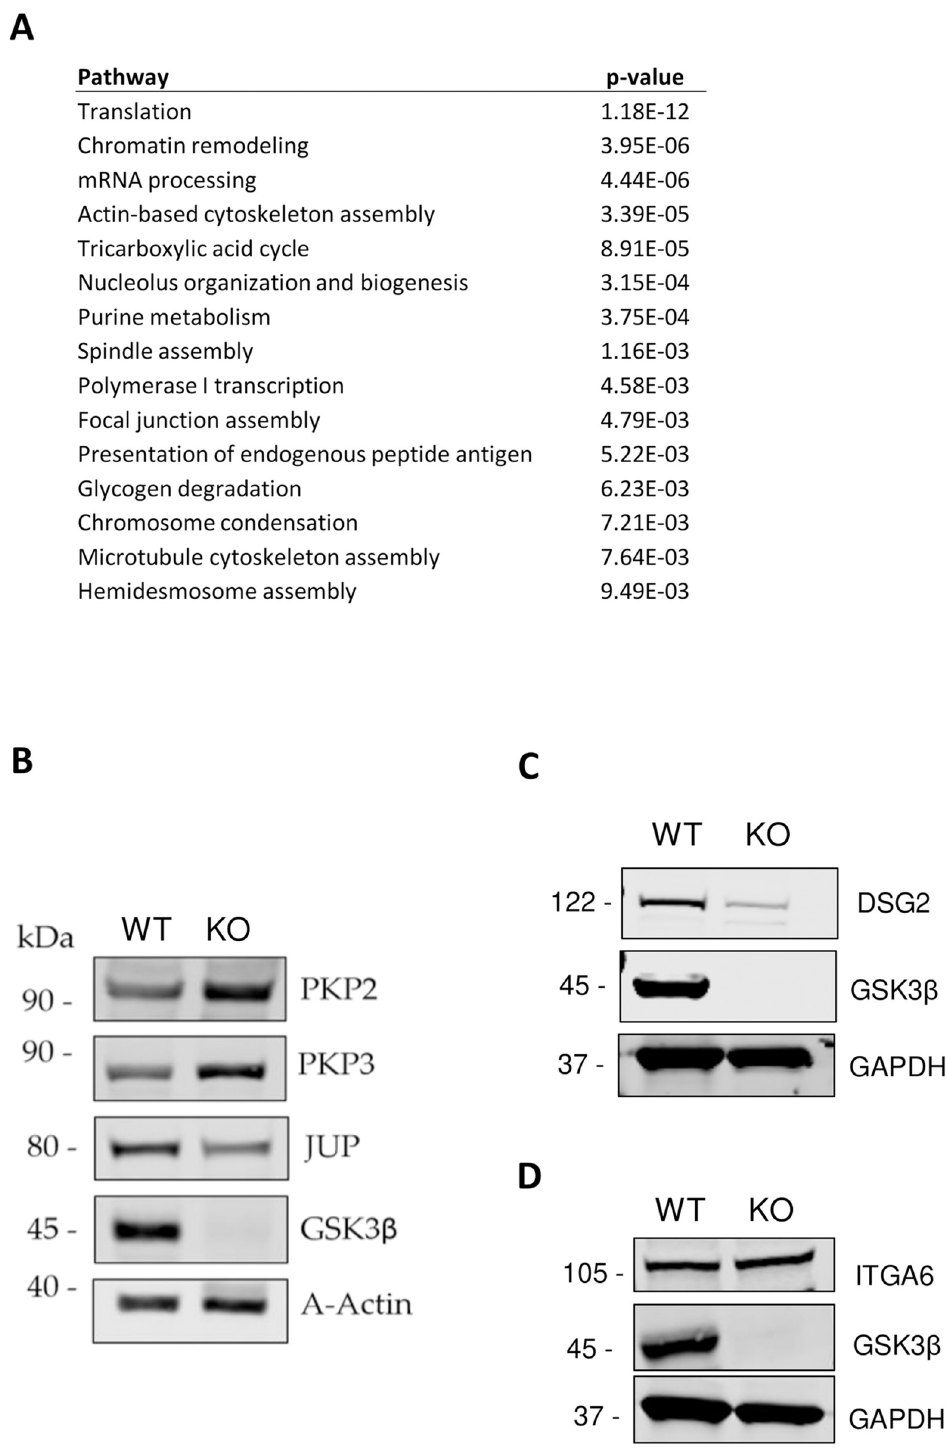
Fig 3. A. Enriched pathways represented in differentially abundant proteins. Enriched pathways were identified using Pathway Studio from the set of differential proteins (p < 0.05). Pathways with significance p < 0.01 are shown and include pathways involved in focal adhesion, hemidesmosomes as well as glycogen metabolism. B. Western blot analysis and mass spectrometry analysis of cell-cell adhesion proteins. 15 μ g of total protein lysates